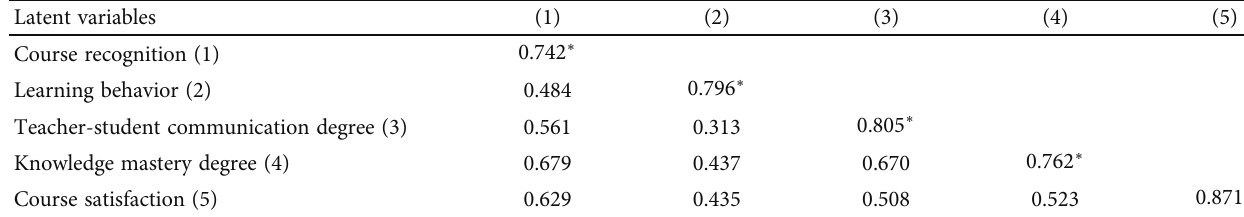
Table 1: Correlation coe ffi cient of latent variables in the model.